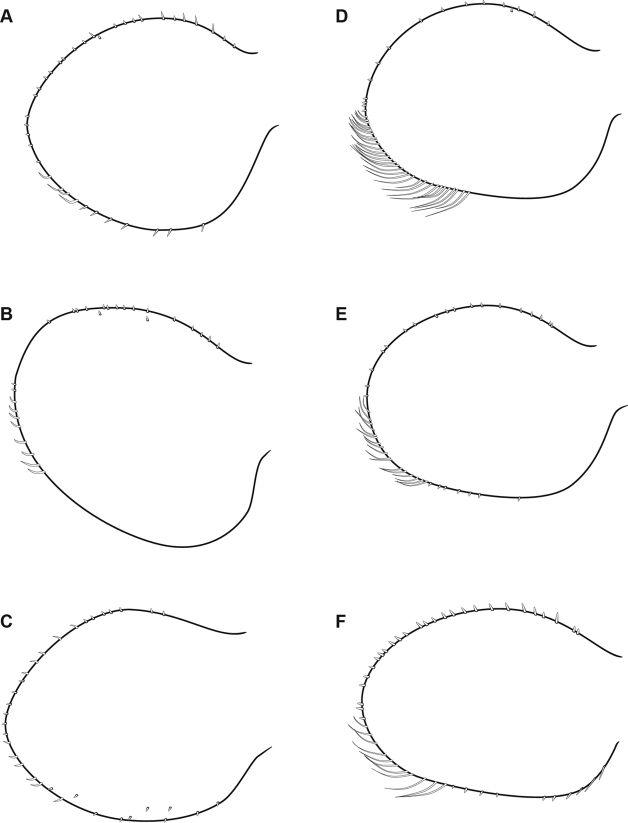
Outline of gill plate III of representative Oligoneuriella (A–C) and Oligoneuriopsis (D–F) species AOligoneuriella
rhenanaBOligoneuriella
pallidaCOligoneuriella
skouraDOligoneuriopsis
lawrenceiEOligoneuriopsis
skhounateFOligoneuriopsis
villosus.